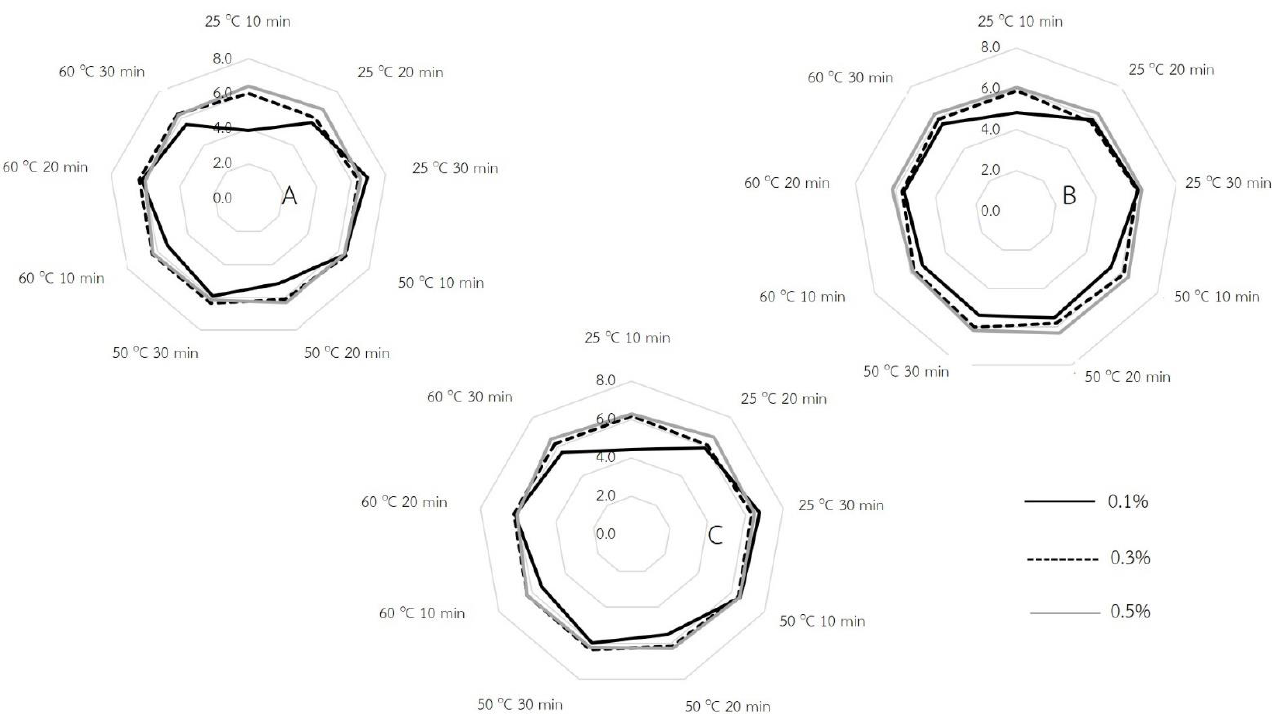
Figure 5. The sensory score of each QBJR sample. ( A ) softener, ( B ) flavor and ( C ) overall